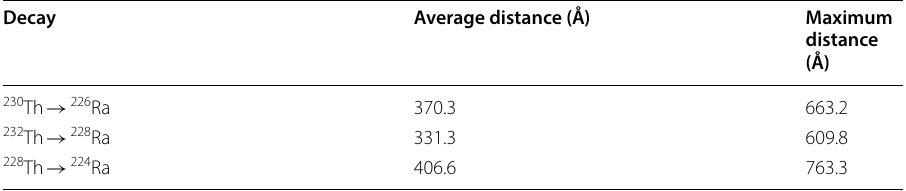
Table 8 Average and maximum recoil distances of radium isotopes in quartz which is chosen as the host due to the mineralogical composition of the aquifer